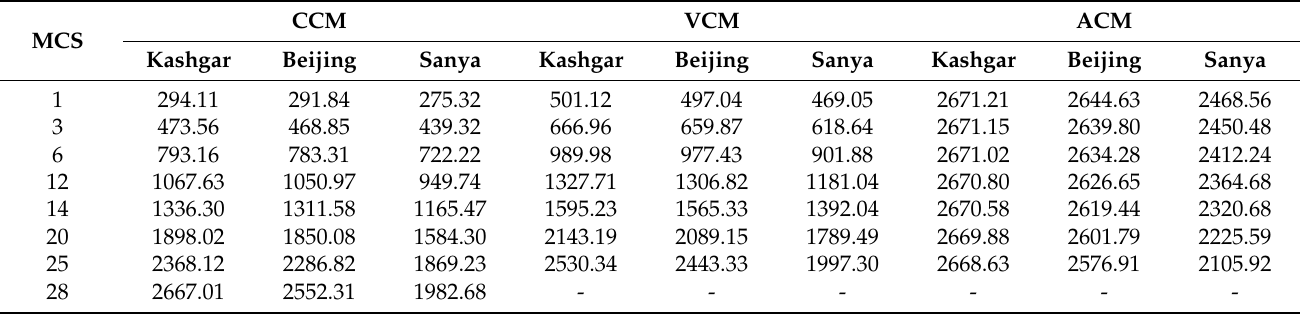
Table 5. CCM, VCM and ACM TEF (Mbps).